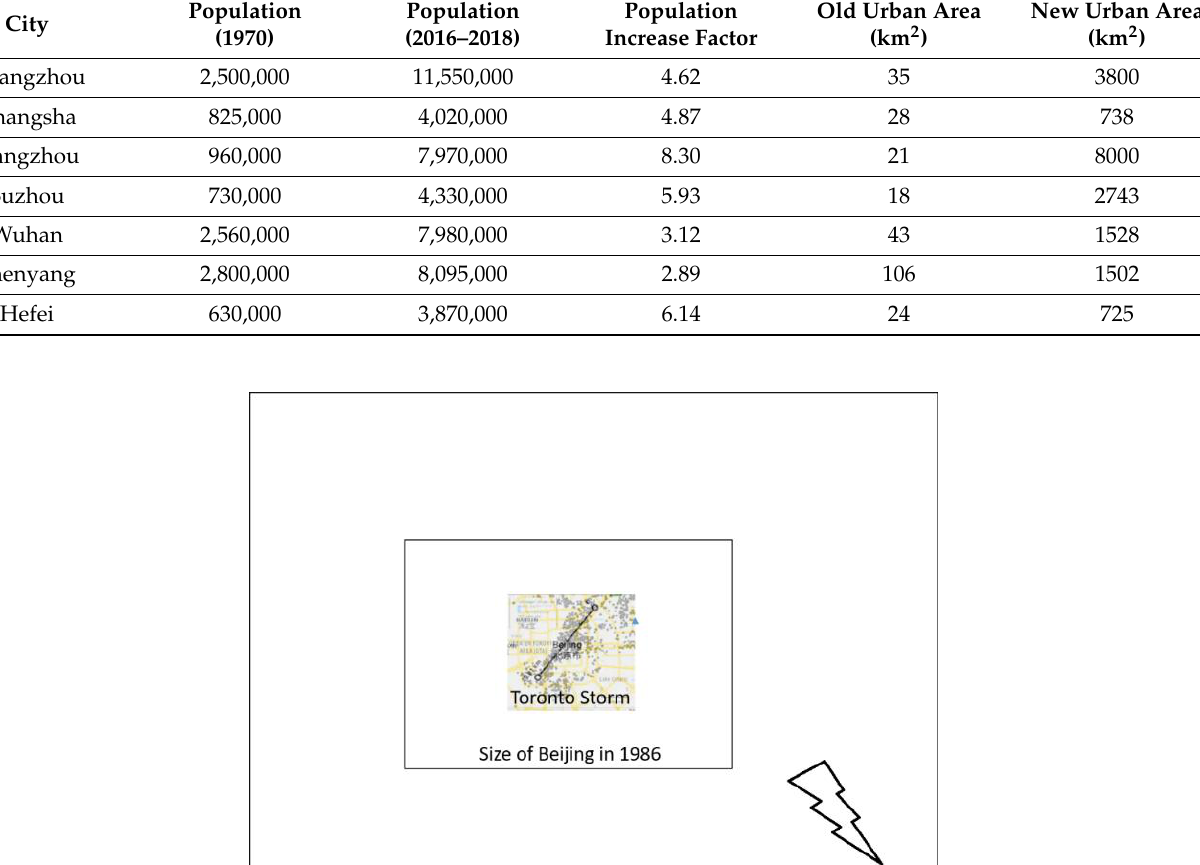
Table 3. Population and urban area for selected Chinese cities (adapted primarily from Lo et al. [35]). City